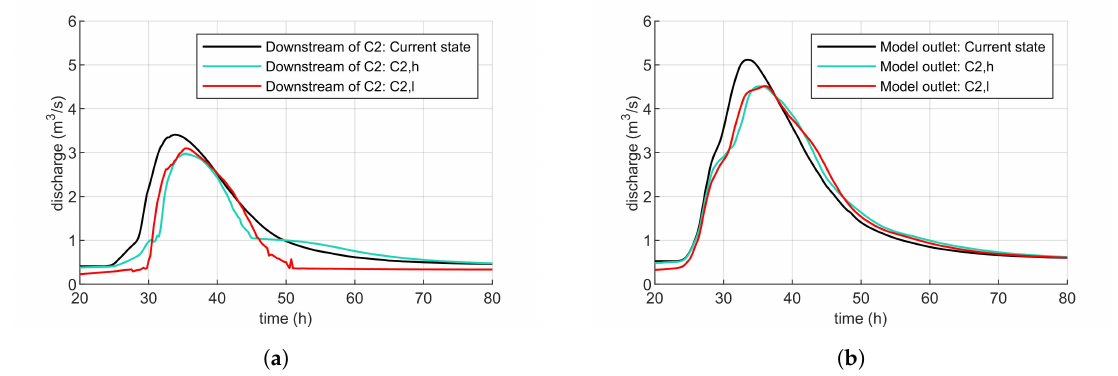
Figure 8. Discharge curves for the E 1,conv flood event at the Glonn for the scenarios C 2,h , C 2,l , and the current state model at different cross sections: ( a ) downstream the cascade C 2 and ( b ) at the model